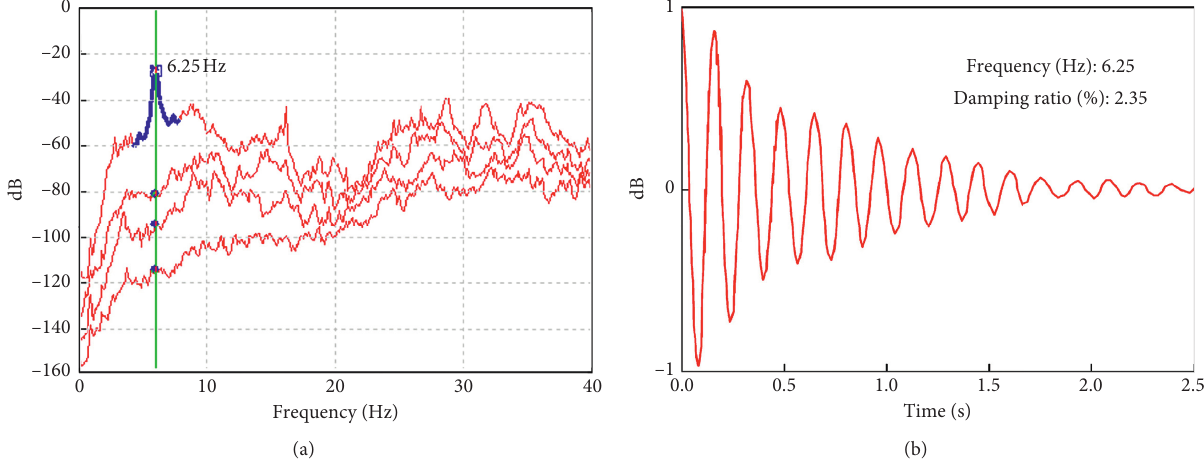
Figure 5: EFDD modal analysis: (a) singular values of the decomposed power spectral density matrices and the BF identification; (b) normalized SDOF autocorrelation curve of the first